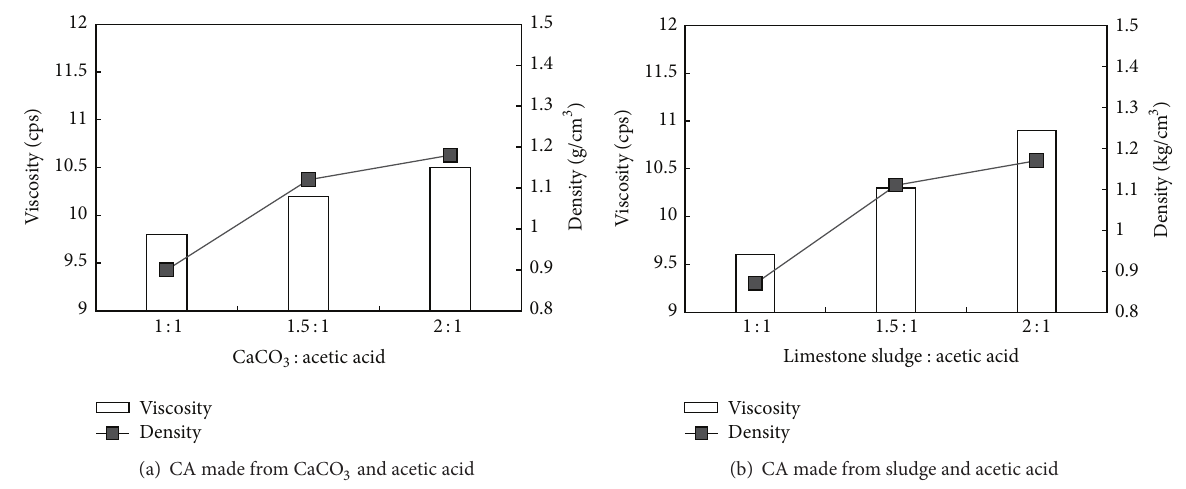
Figure 4: Viscosity and density of calcium acetate.